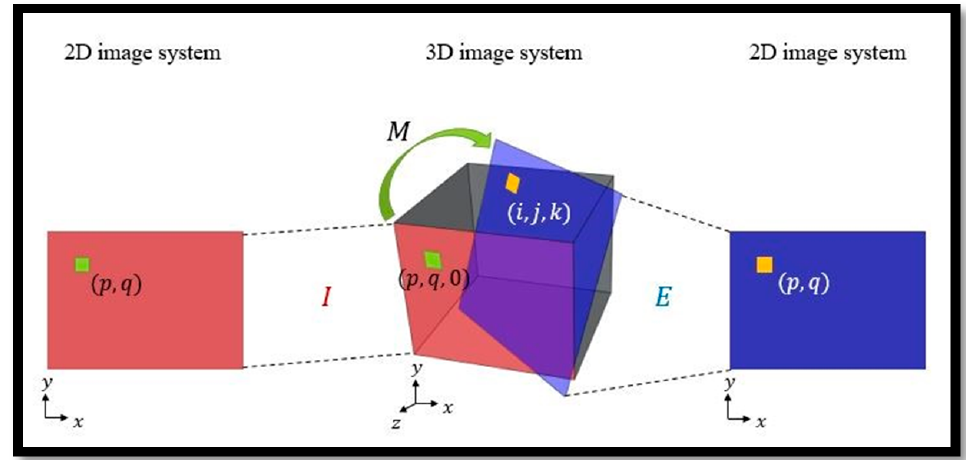
Figure 7. Illustration of the transformation between two planes where M is a transformation and I is the initial sagittal plane. Each pixel ( p , q ) of I , i.e., a voxel ( p , q , 0) in the 3D image space, is transformed to ( i , j , k ) on E through M whose intensity value is mapped onto the corresponding coordinate ( p , q ) of E .